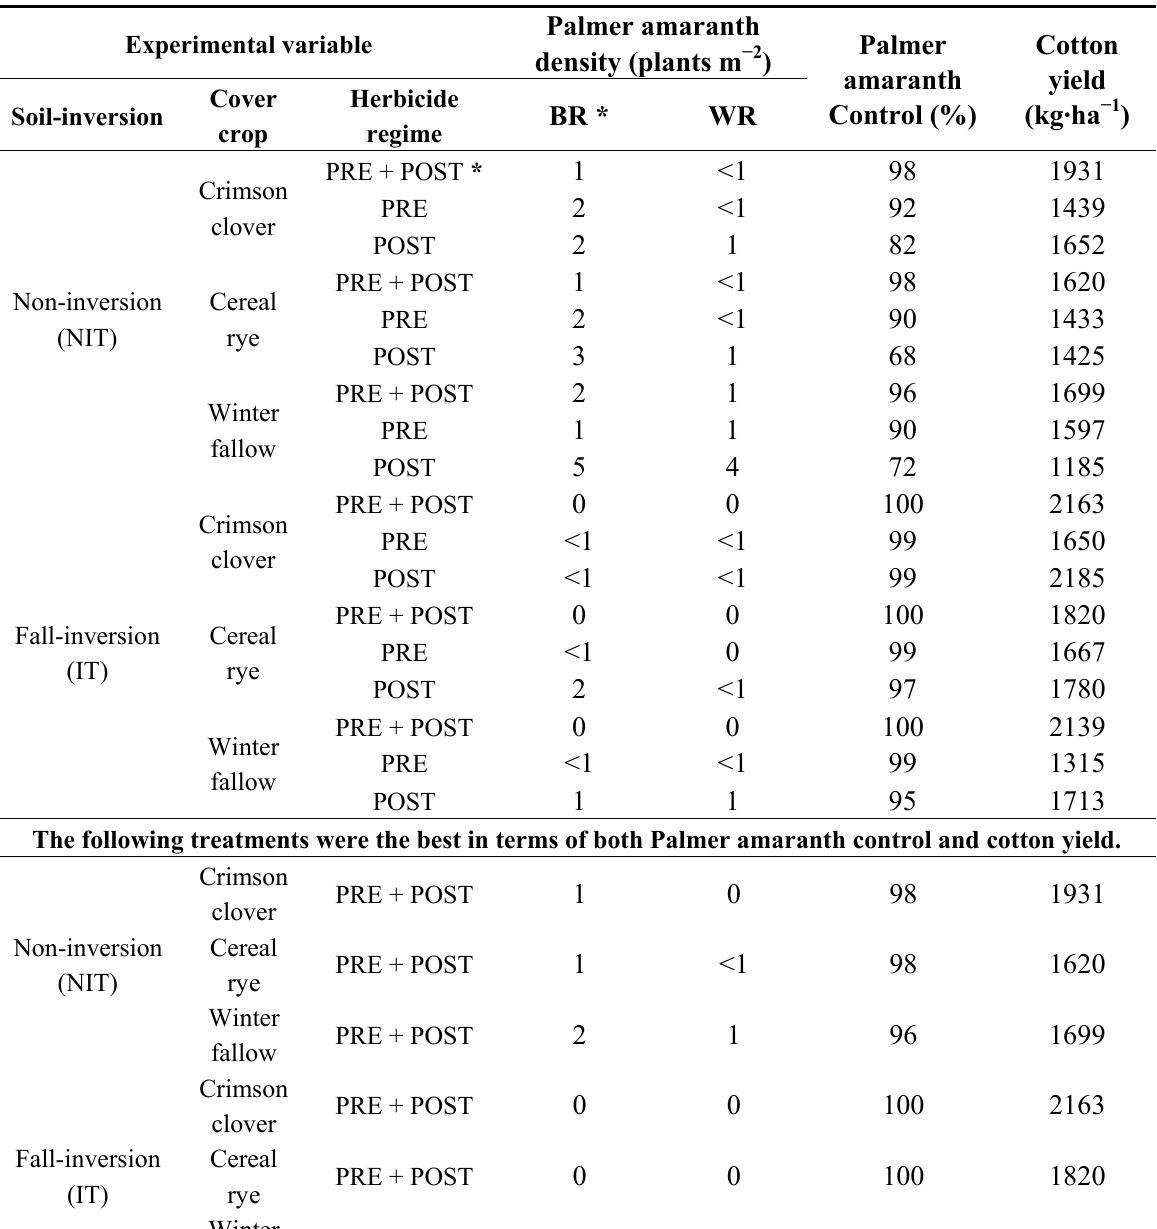
Table 8. Palmer amaranth density and visual percent control at 6 WAP * and cotton yield from selected treatments with data combined over three production